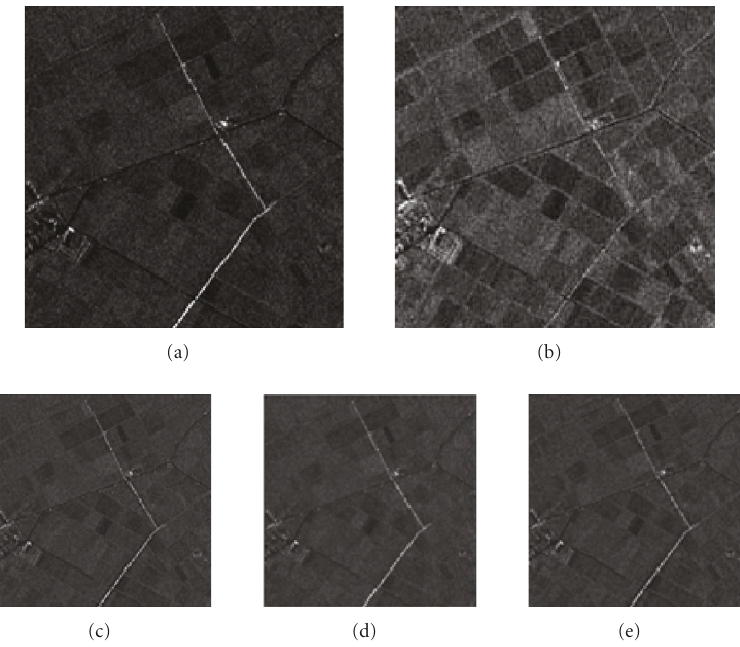
Figure 12: Fusion of two (a) HH, (b) HV, (c) pyramid-based, (d) model-based and, (e) turbo iterative-based.